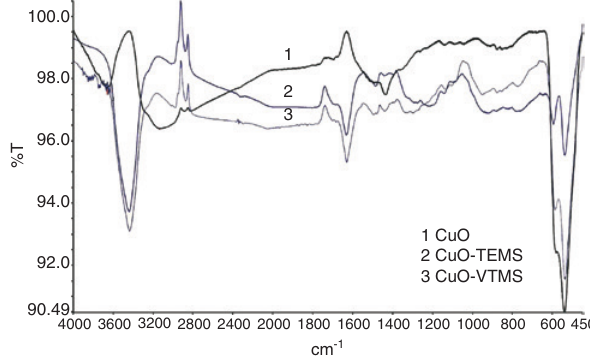
Figure 3: FT-IR spectra of pure and modified nano CuO.